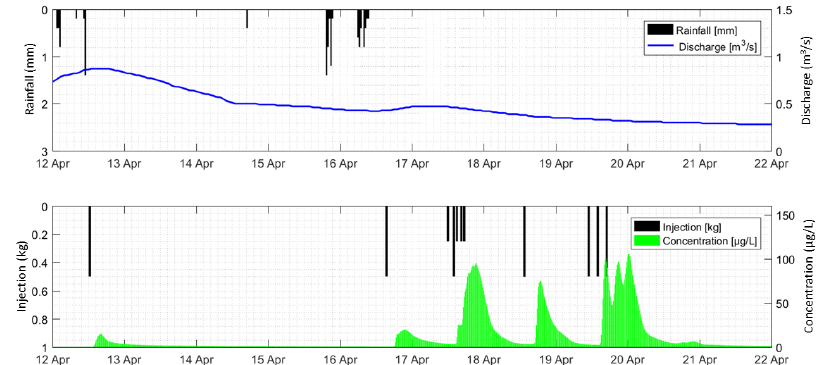
Figure 2. Rainfall-discharge time series during artificial tracer tests and injection recovery time series. The artificial tracer tests have been performed in April 2018 (modified from [13]).